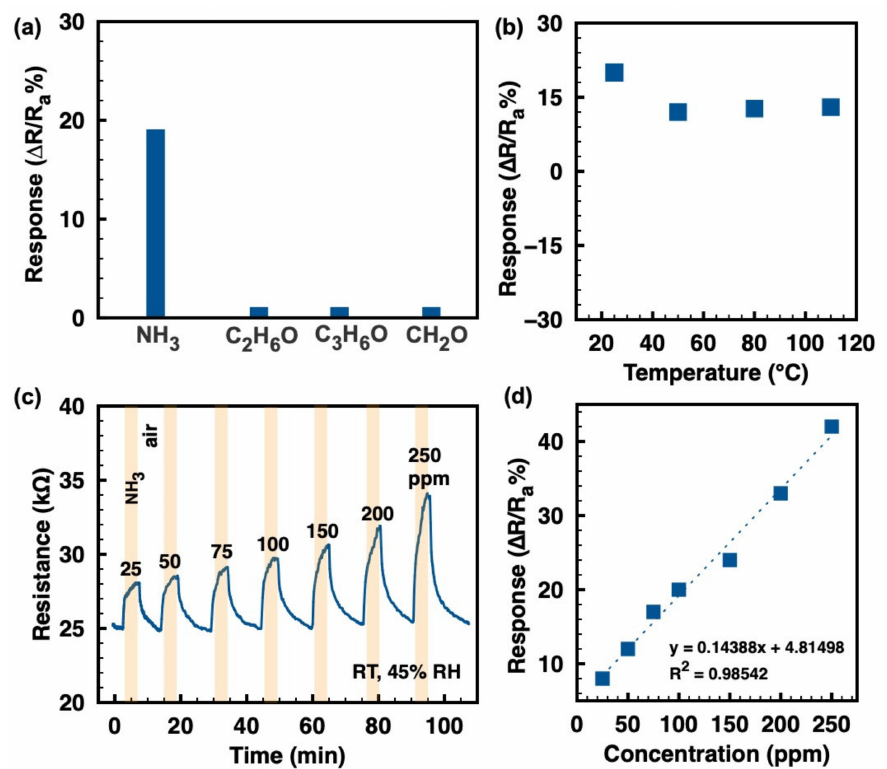
Figure 3. ( a ) Selectivity toward various gases (ammonia, ethanol, acetone, and formaldehyde) of 100 ppm at RT; ( b ) response values to 100 ppm ammonia at different working temperatures; ( c ) continuous resistance vs. time to ammonia at a variety of concentrations at RT; ( d ) the correspond- ing relationship of response values to ammonia and concentrations, with linear-fitting dashed